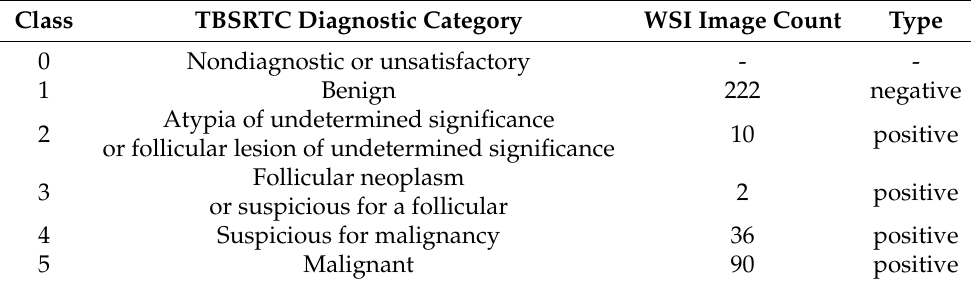
Table 2. The distribution of WSIs.